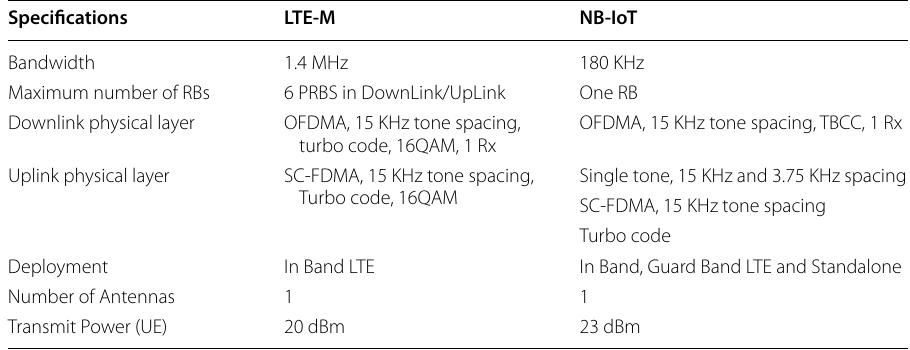
Table 2 Difference between LTE‑M and NB‑IoT